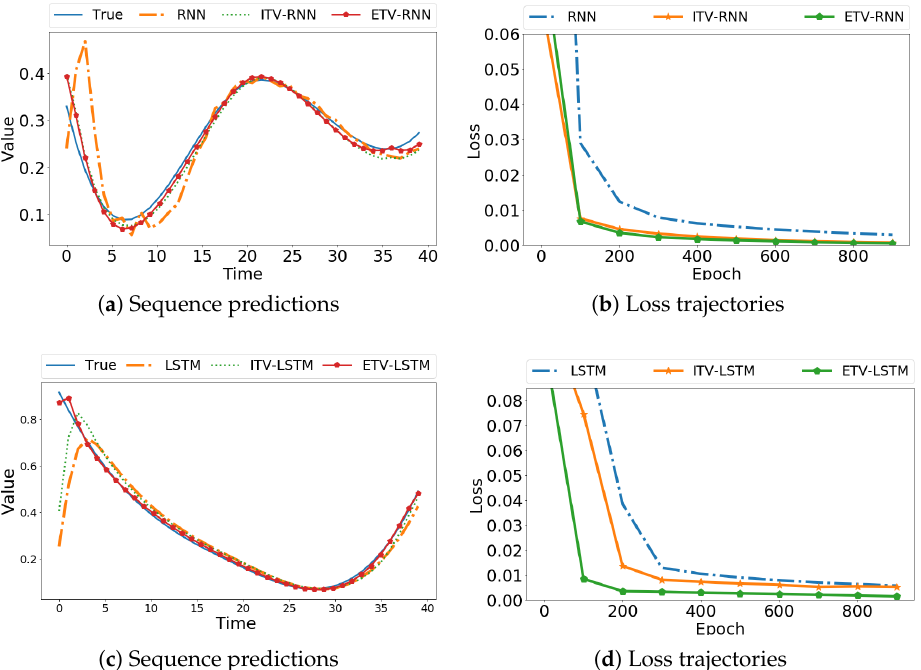
Figure 3. Prediction of smooth noise-free simulation data using the original model, ITV, and ETV, respectively.